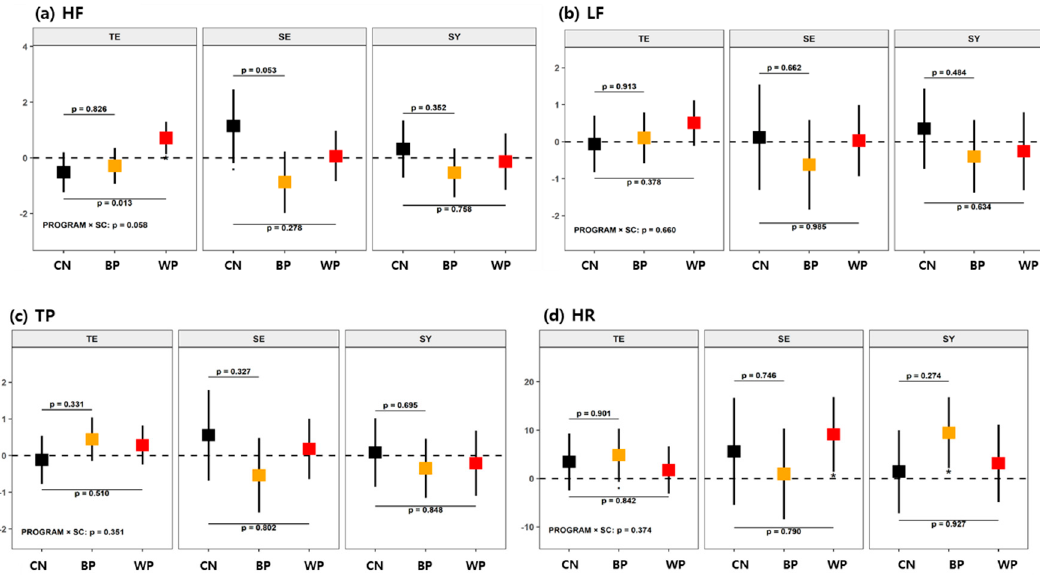
Figure 5. Mean changes in HRV variables after each of the FTPs according to SC type for ( a ) high frequency (HF), ( b ) low frequency (LF), ( c ) total power (TP), and ( d ) heart rate (HR). The details are identical to those in Figure 3.